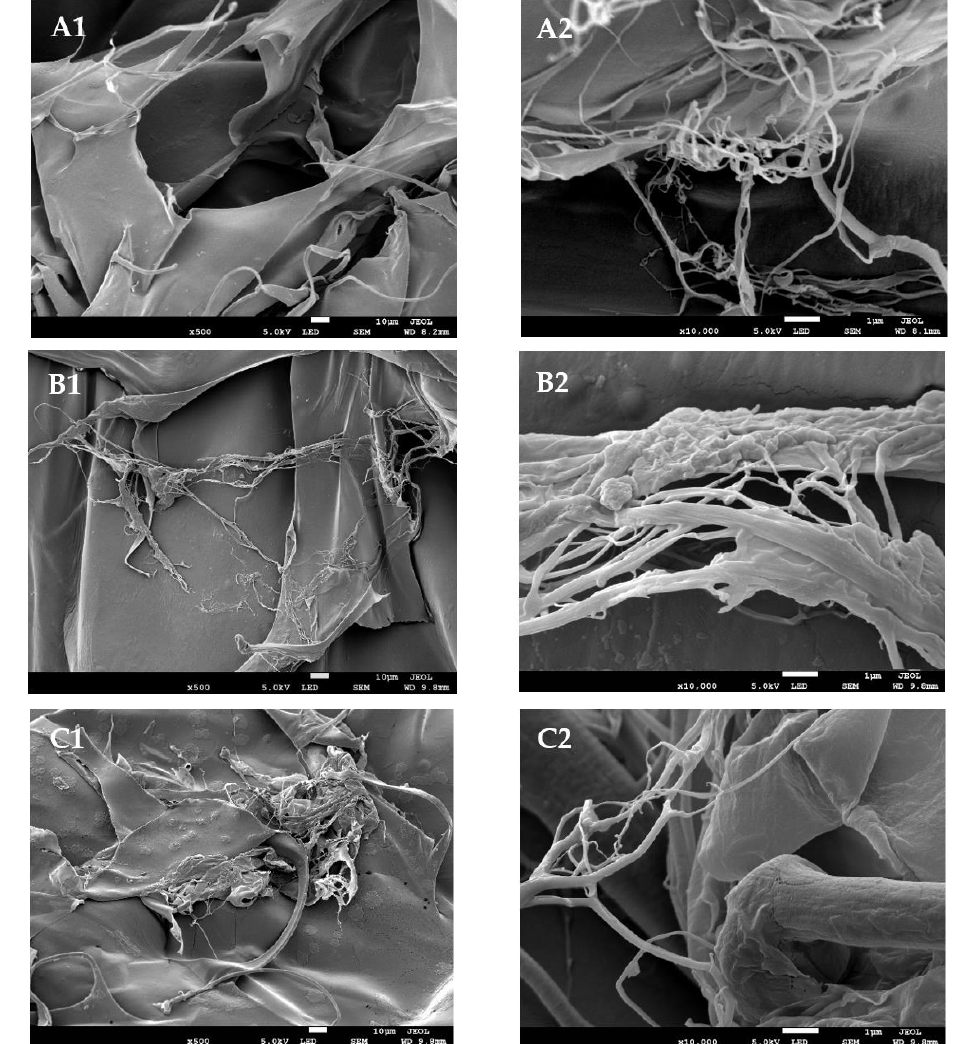
Figure 6. Field emission scanning electron microscopy images (FESEM) of lizardfish skin collagens extracted with different acids. ( A1 ) acetic acid-extracted collagen at 500× magnification; ( A2 ) acetic acid-extracted collagen at 10,000× magnification; ( B1 ) lactic acid-extracted collagen at 500× magnifi- cation; ( B2 ) lactic acid-extracted collagen at 10,000× magnification; ( C1 ) citric acid-extracted collagen at 500× magnification; ( C2 ) citric acid-extracted collagen at 10,000× magnification.